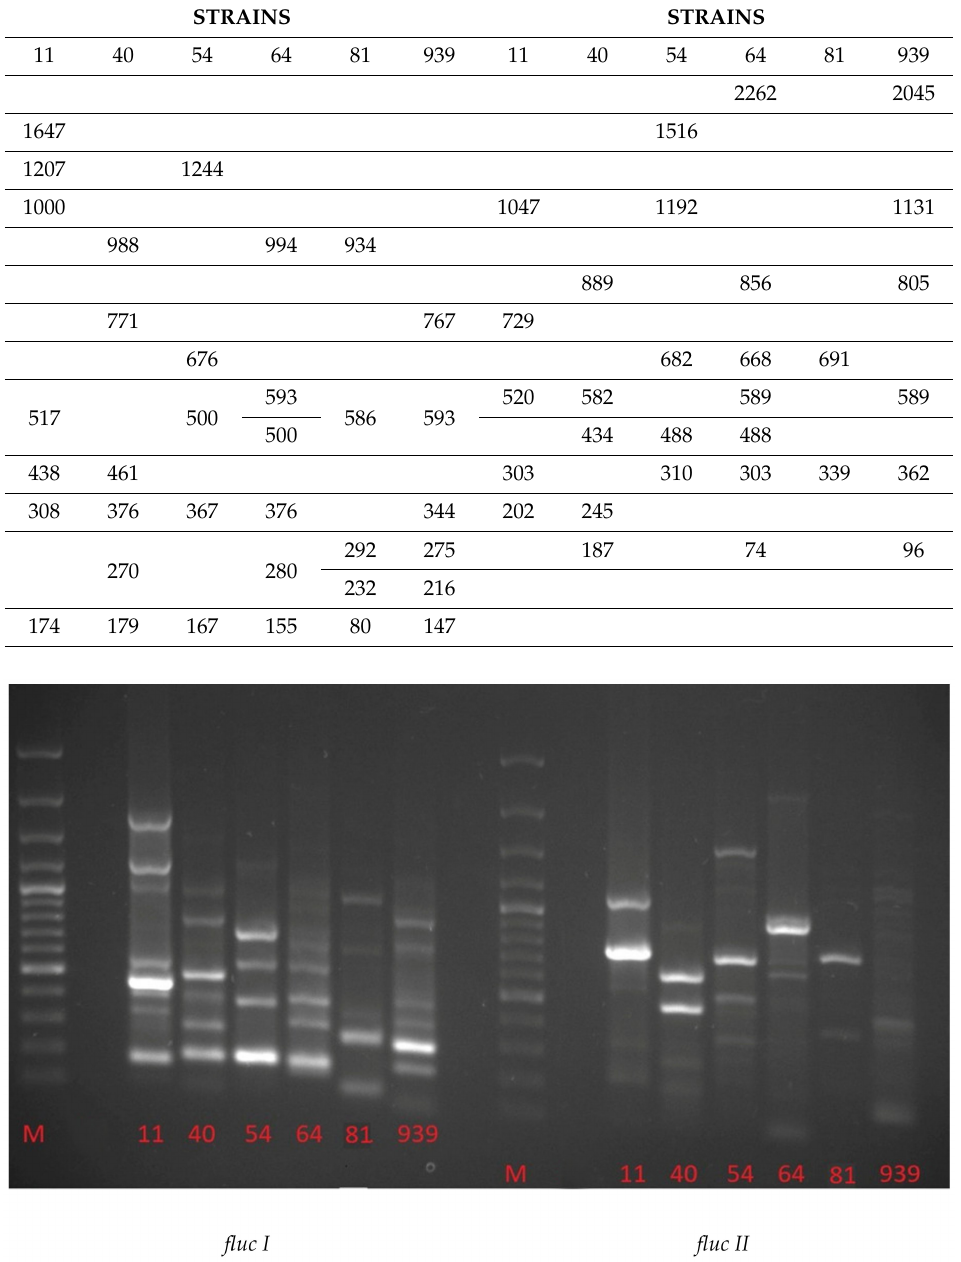
Figure 3. Electrophorogram obtained from PCR with fluc I and fluc II primers (M—marker GeneRuler 1000